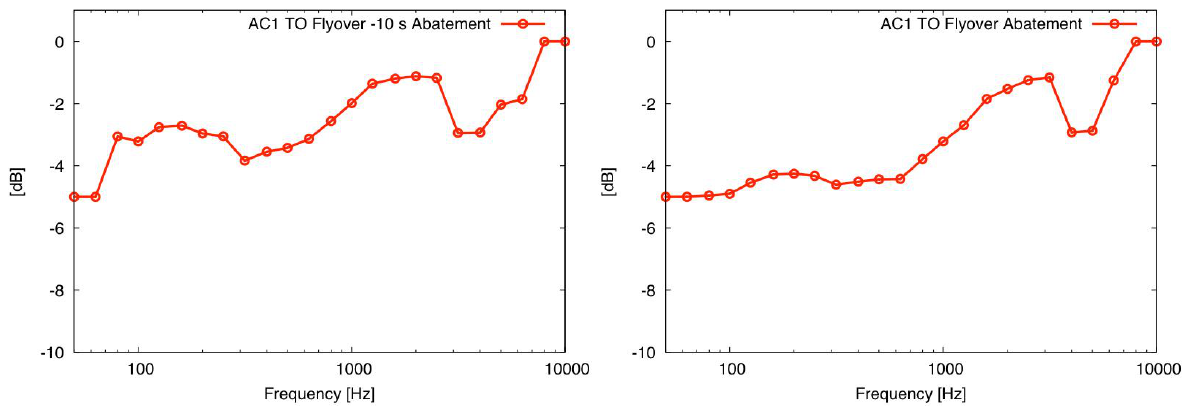
Figure 8: Noise abatement spectra produce by LNT at flyover for the fan (left) and jet (right) noise.